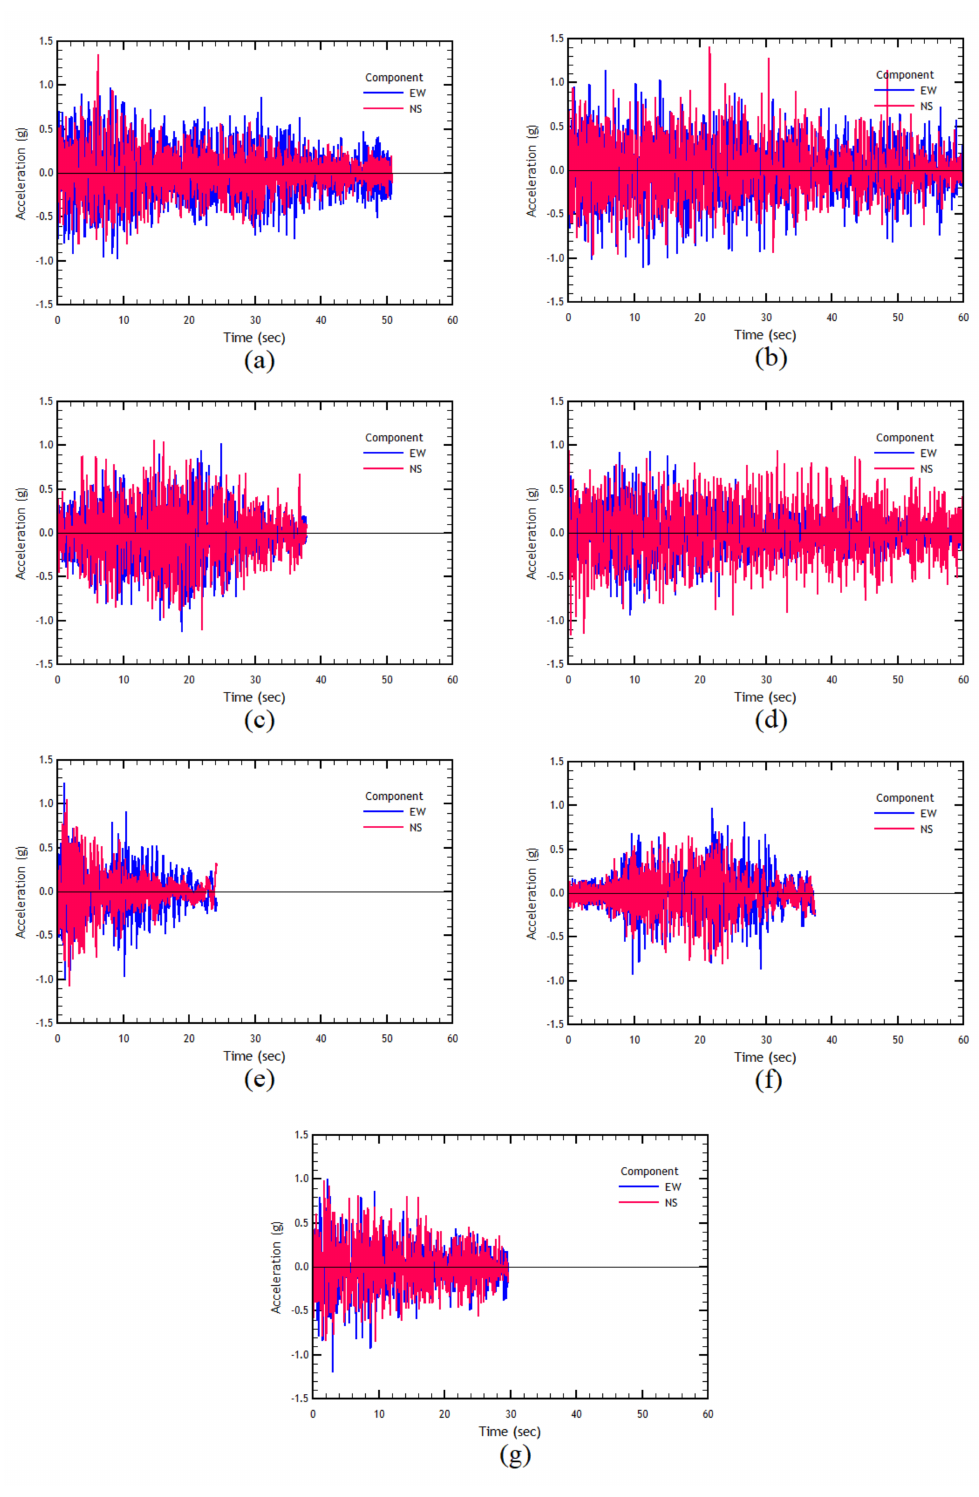
Figure 7. ( a ) Maule earthquake, Angol station record; ( b ) Maule earthquake, Concepcion station record; ( c ) Maule earthquake, Llolleo station record; ( d ) Maule earthquake, Constitucion station record; ( e ) Coquimbo earthquake, El Pedregal station record; ( f ) Coquimbo earthquake, San Esteban station record ( g ) Coquimbo earthquake, Tololo station